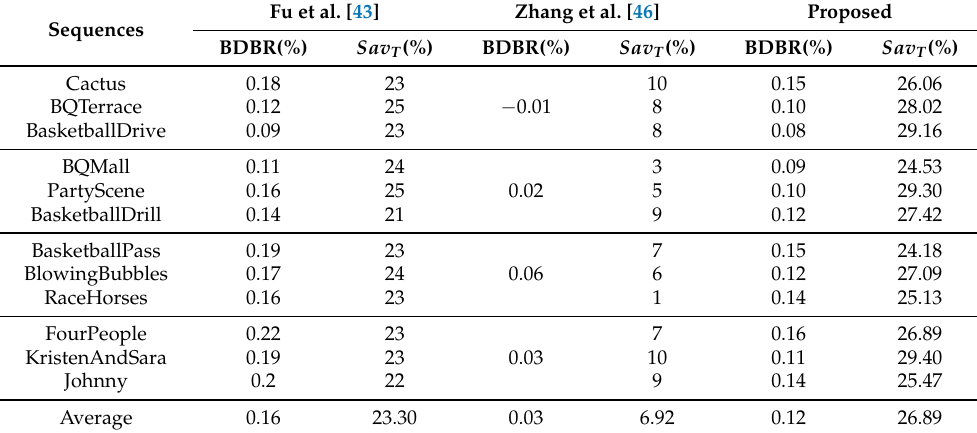
Table 7. The proposed algorithm compared to the state-of-the-art experimental results.